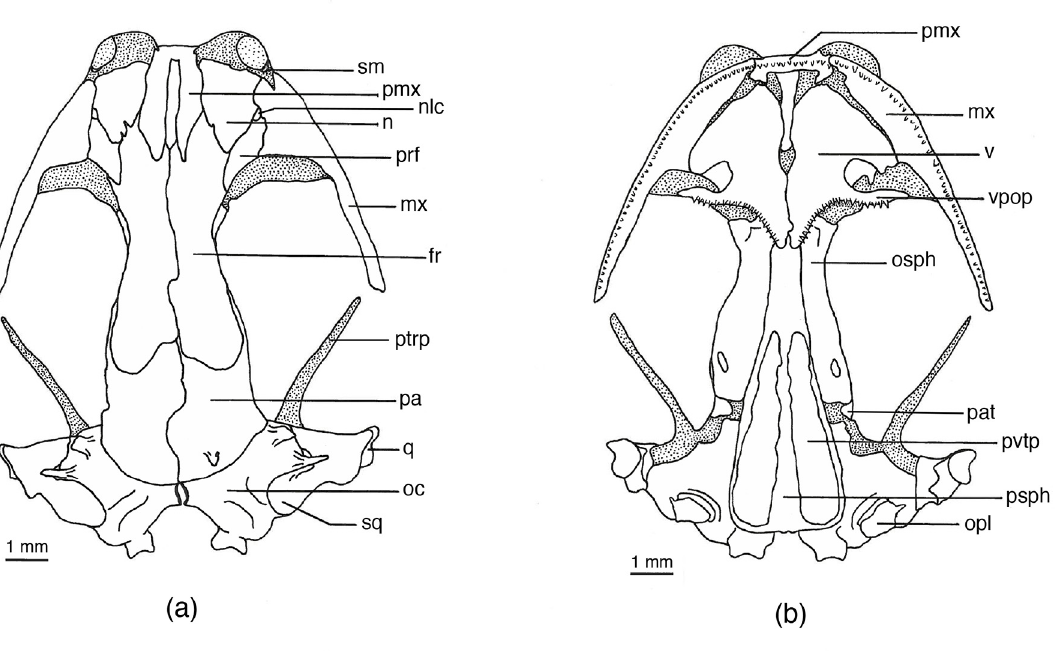
Fig 2. Chiropterotriton magnipes skull. Drawings of dorsal (a) and ventral (b) aspects of the skull of Chiropterotriton magnipes (MVZ 129021). Stippled areas represent cartilage. Posterior patch of vomerine teeth is outlined. Abbreviations: fr = frontal, mx = maxilla, n = nasal, nlc = nasolacrimal canal, oc = otic capsule, opl = opercular plate, osph = orbitosphenoid, pa = parietal, pat = parietal tab, pmx = premaxilla, prf = prefrontal, psph = parasphenoid, ptrp = pterygoid process, q = quadrate, sm = septomaxilla, sq = squamosal, v = vomer, vpop = vomer preorbital process, pvtp = posterior vomerine tooth